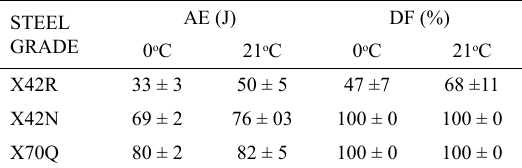
Table 4. Charpy impact properties of the studied